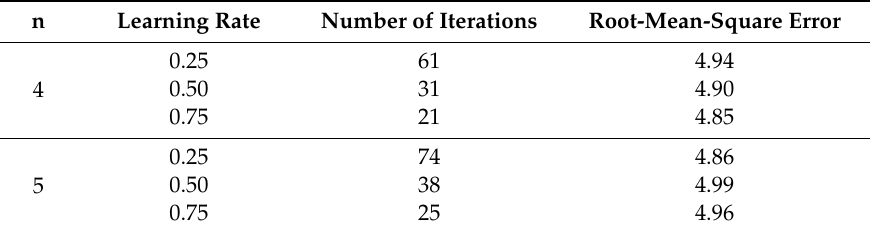
Figure 9. Comparison between desired outputs and actual outputs ( β = 0.75, RMSE = 4.96). Comparison from the perspectives of parameter learning rate, number of iterations, and root-mean-square error under di ff erent numbers of variables in Layer 2 is shown in Table 8. Table 8. Data fusion results under di ff erent numbers of